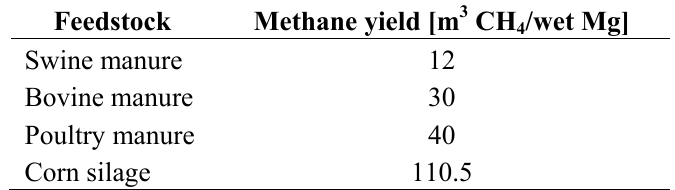
Table 4. Methane yield from selected feedstock in the AD process